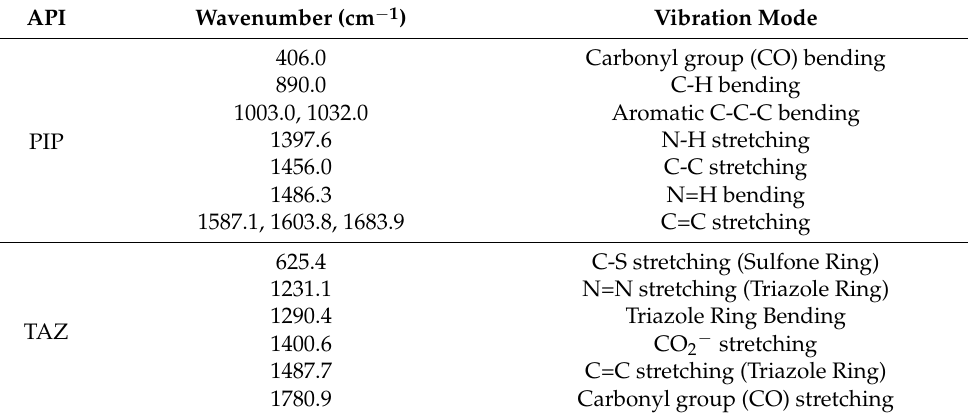
Table 1. Characteristic peaks of pure APIs and their attribution to vibration modes according to bibliography.